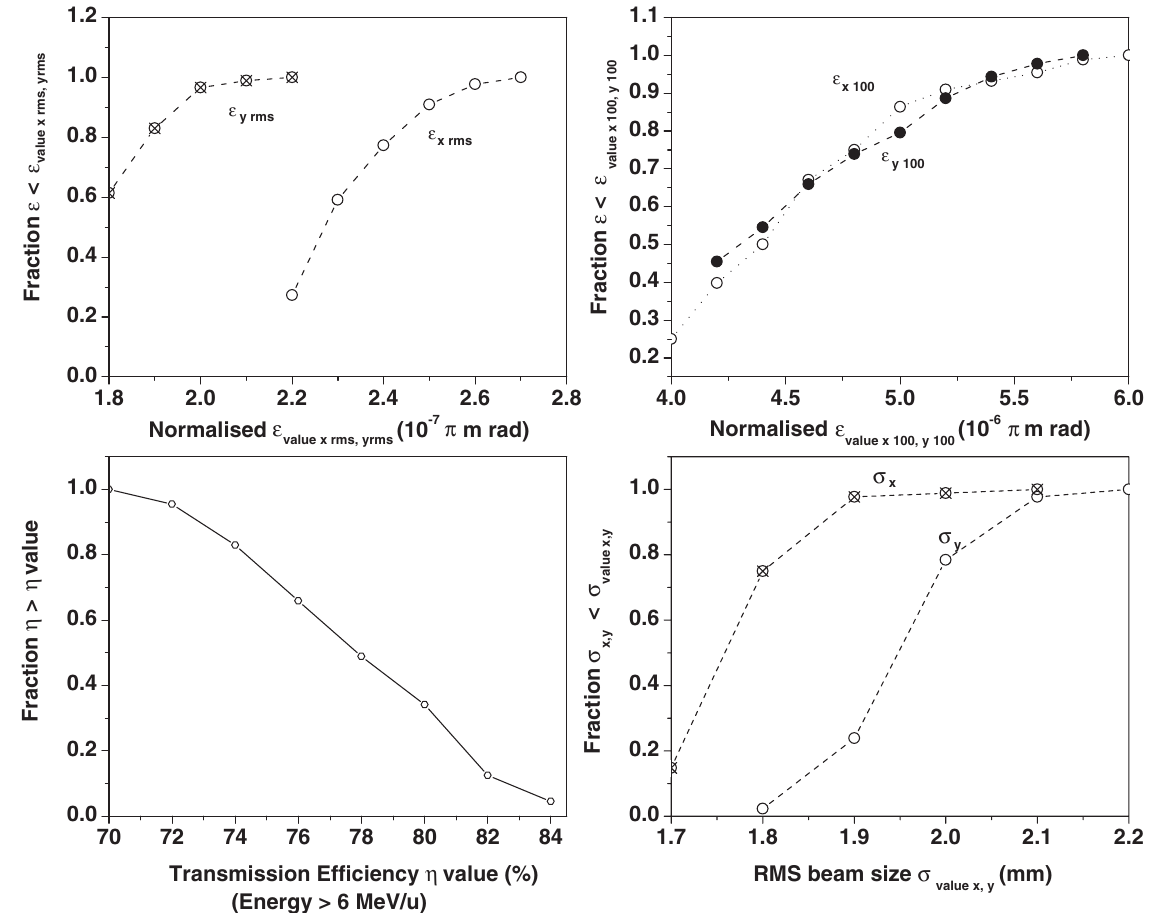
FIG. 8. Probability distribution for transmission efficiency (energy > 6 MeV = u), transverse emittance and rms beam